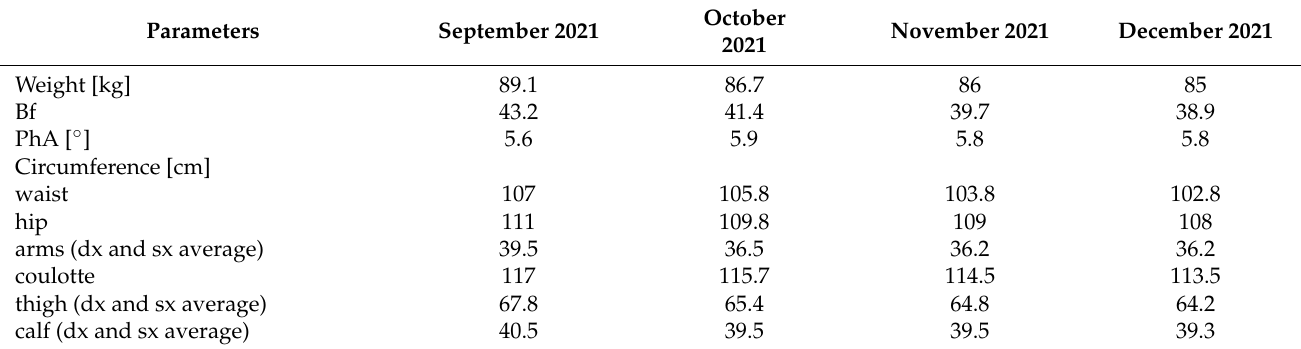
Table 2. Anthropometric parameters.